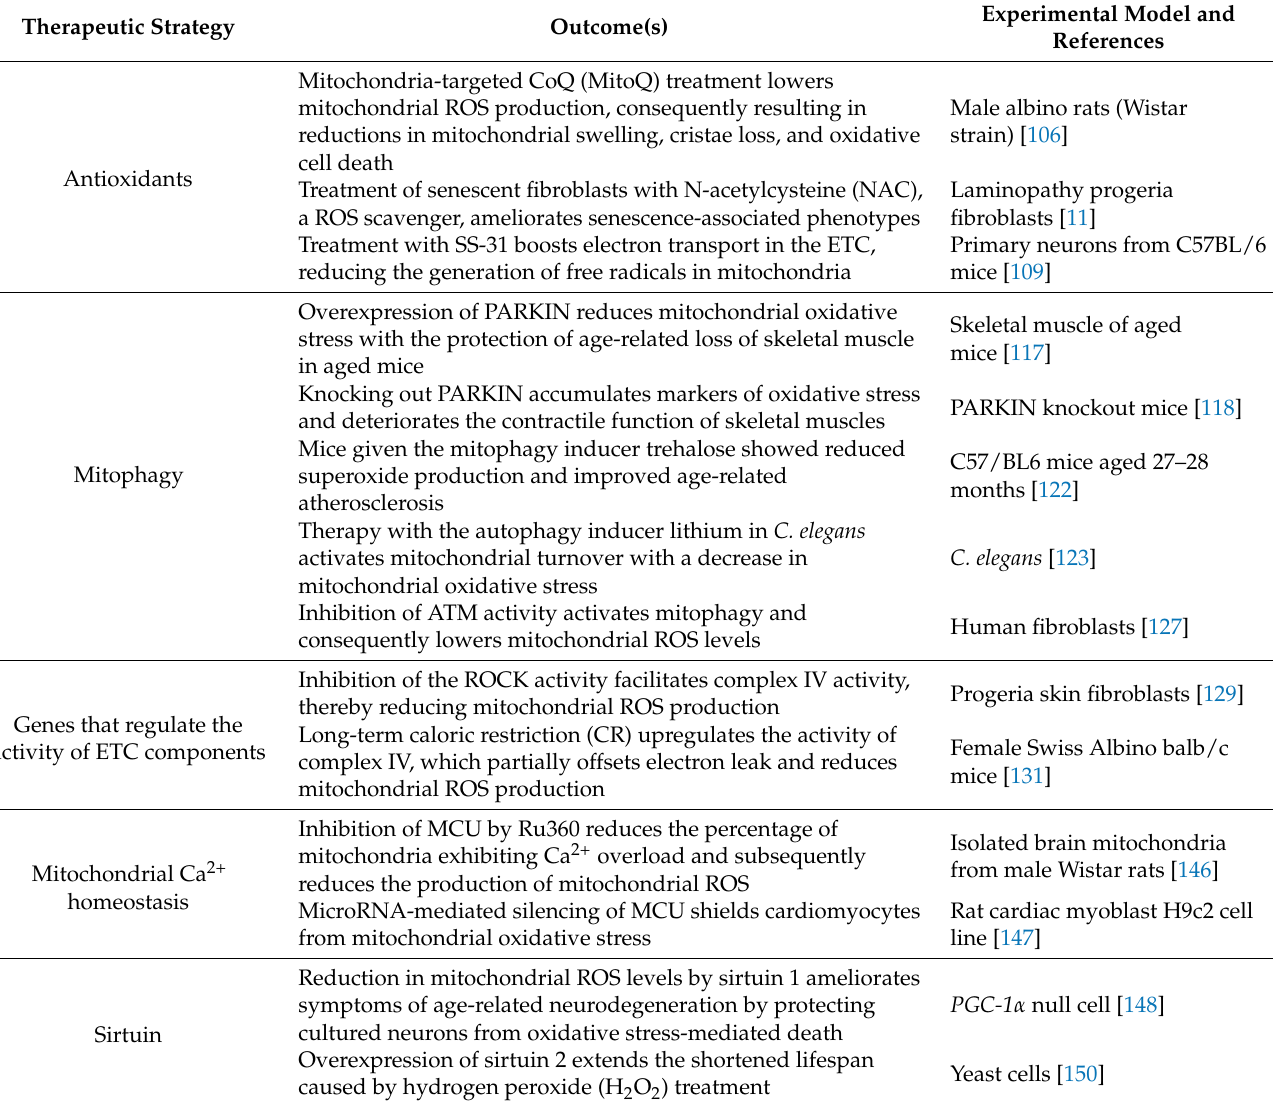
Table 3. Targeting mitochondrial oxidative stress as a therapeutic strategy for aging and age- related